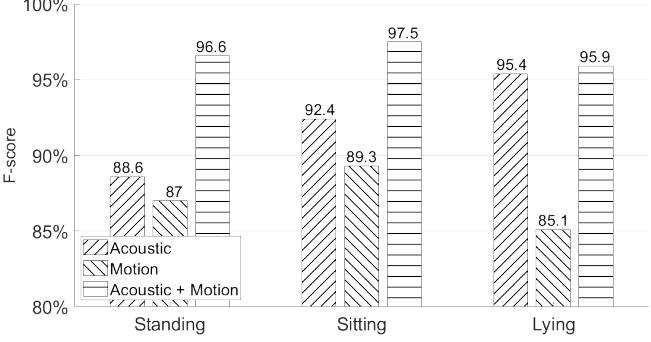
Figure 16. Different poses’ authentication performances—standing, sitting, and lying.